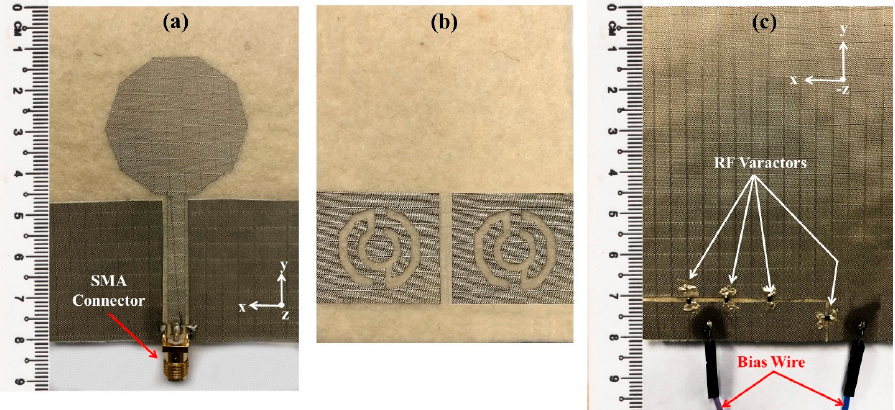
Figure 8. Fabricated prototype of the MTM driven reconfigurable antenna. ( a ) Top layer, ( b ) MTM layer, and ( c ) bottom layer.